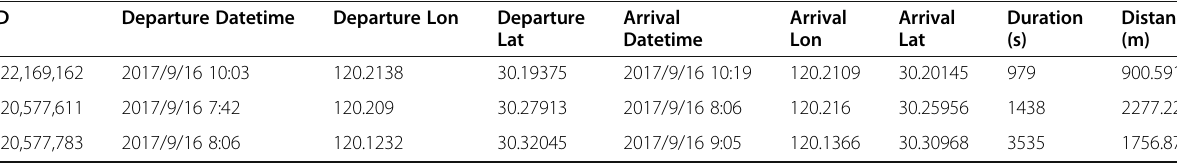
Table 1 Samples of the delivery order